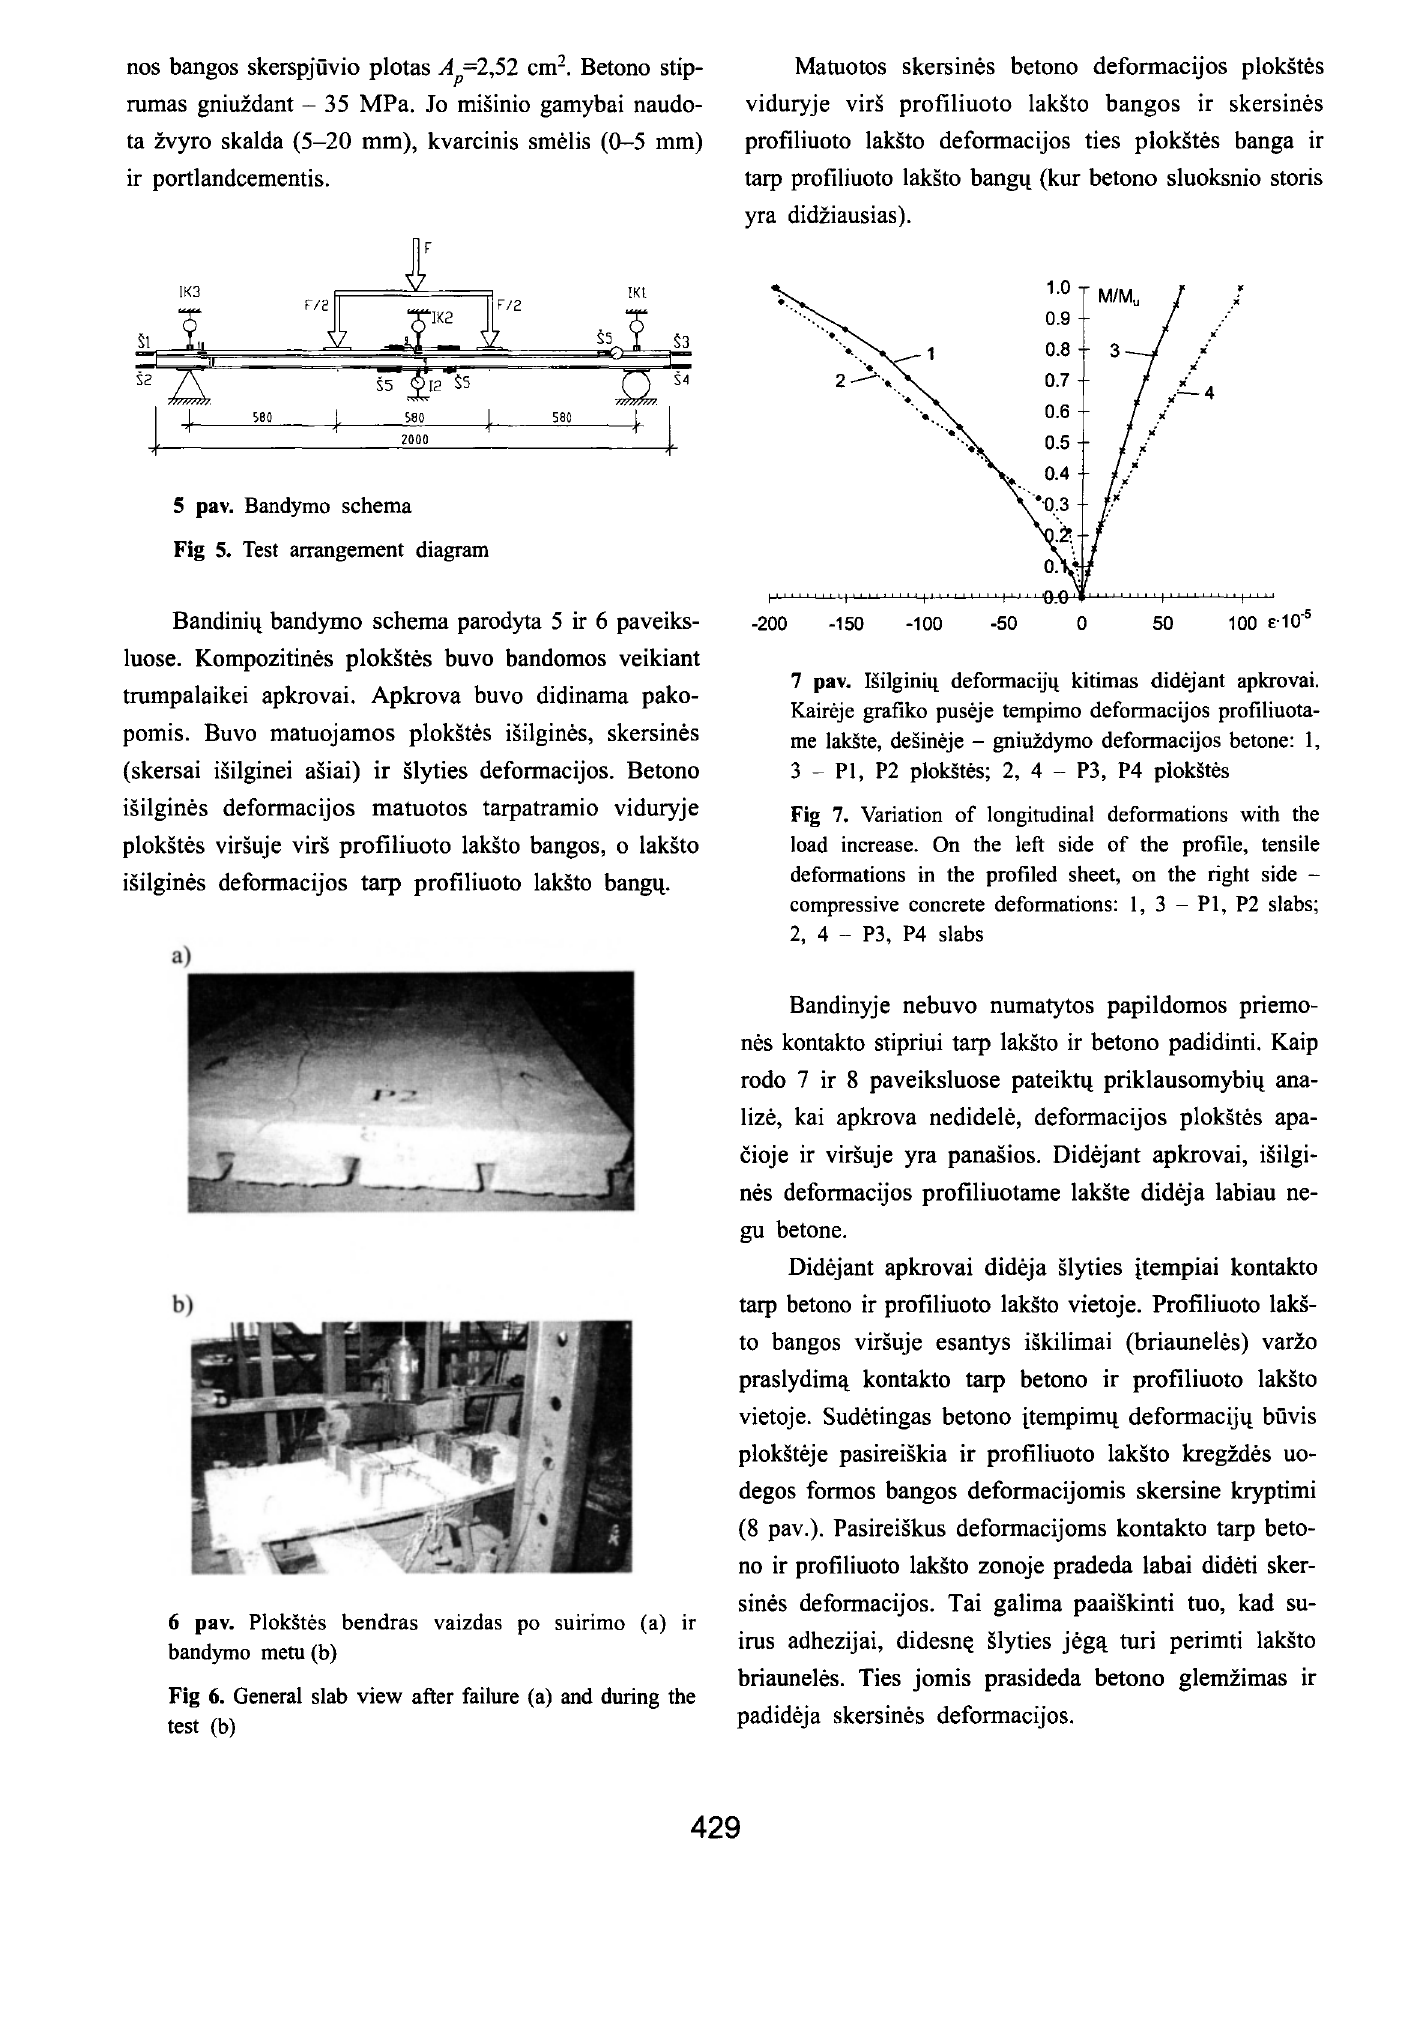
Fig 6. General slab view after failure (a) and during the